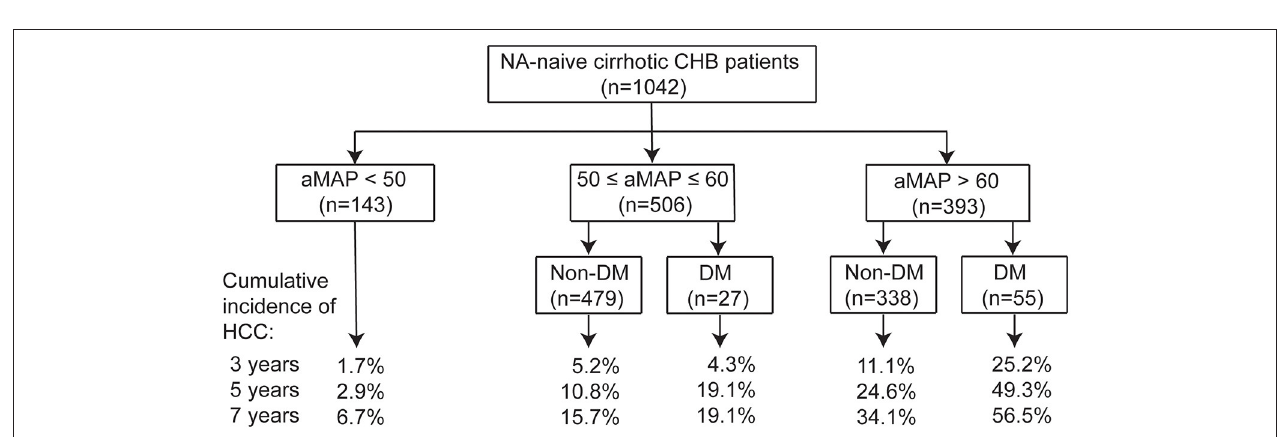
FIGURE 4 | Proposed algorithm for prediction of HCC risk by combination of aMAP and DM in NA-naïve cirrhotic CHB patients.